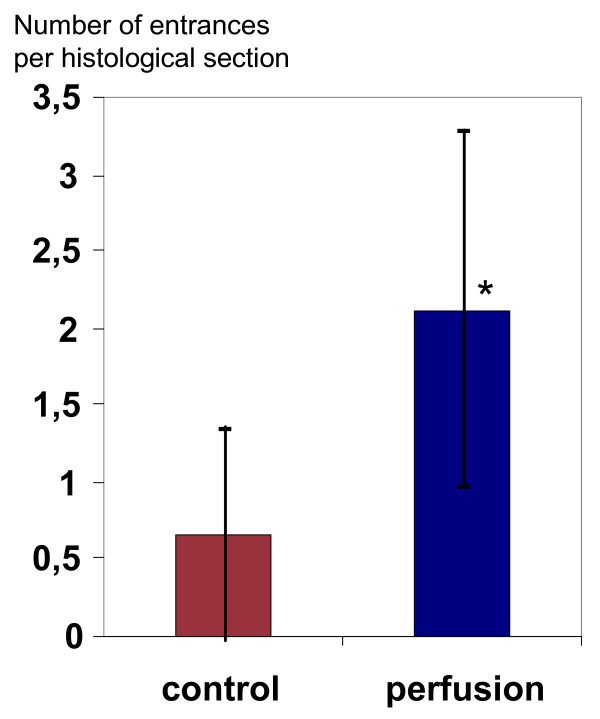
Count of entrances